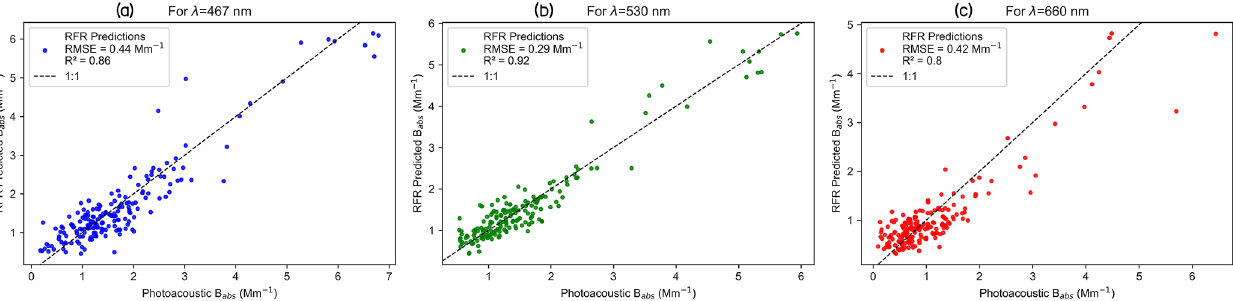
Figure 6. Random forest regression, a supervised machine learning algorithm, applied to correct for PSAP absorption coefficients, and comparison of its performance with reference PASS absorption coefficients measured at the SGP site corresponding to the (a) 467nm, (b) 530nm, and (c) 660nm